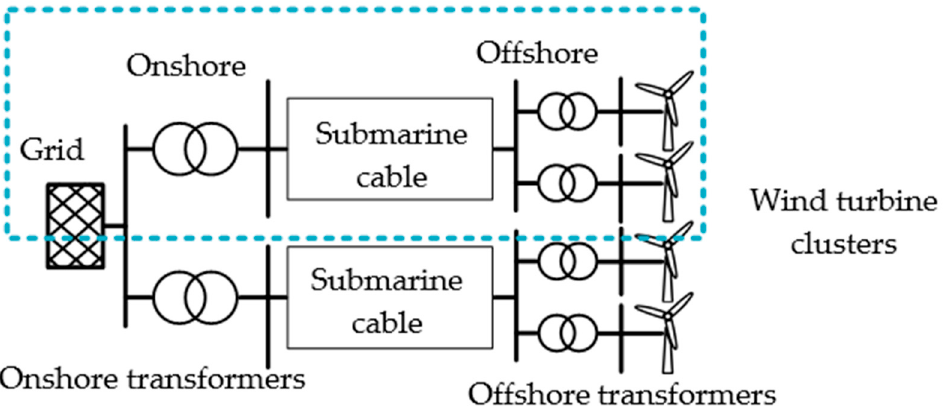
Figure 2. Benchmark modular offshore wind farm structure connected to the grid.